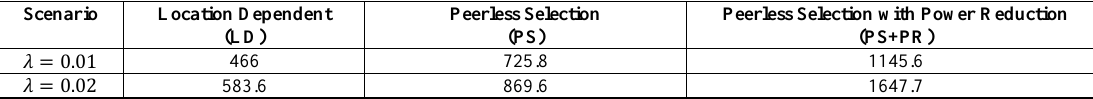
Table 2. Throughput Comparison between different schemes under different 𝝀